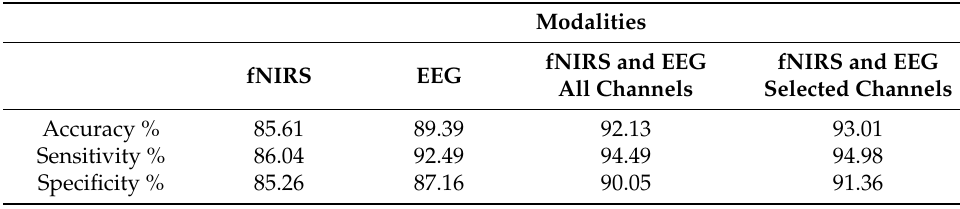
Table 5. Classification